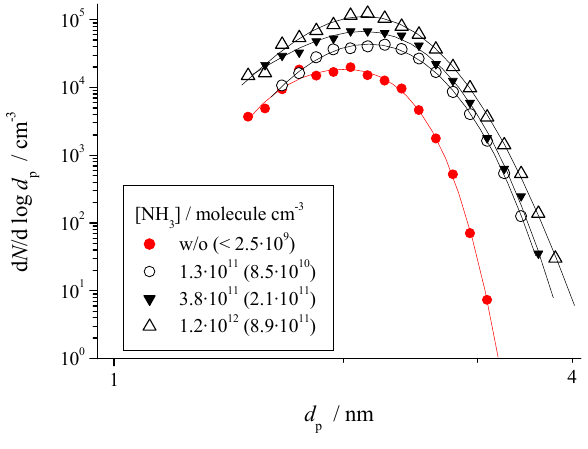
Fig. 3. Measured particle number size distributions over the size Figure 3. Measured particle number size distributions over the size range of 1.5–4 nm in range of 1.5–4nm in nucleation experiments conducted at differ- nucleation experiments conducted at different ammonia concentration levels. The H 2 SO 4 ent ammonia concentration levels. The H 2 SO 4 concentration was 1.2 × 10 8 moleculescm − 3 and the relative humidity was 22%. The concentration was 1.2×10 8 molecules cm –3 and the relative humidity was 22%. The given given NH 3 concentrations refer to those inside the inlet and the cor- NH 3 concentrations refer to those inside the inlet and the corresponding outlet responding outlet concentrations are presented in the concentrations are presented in the brackets.